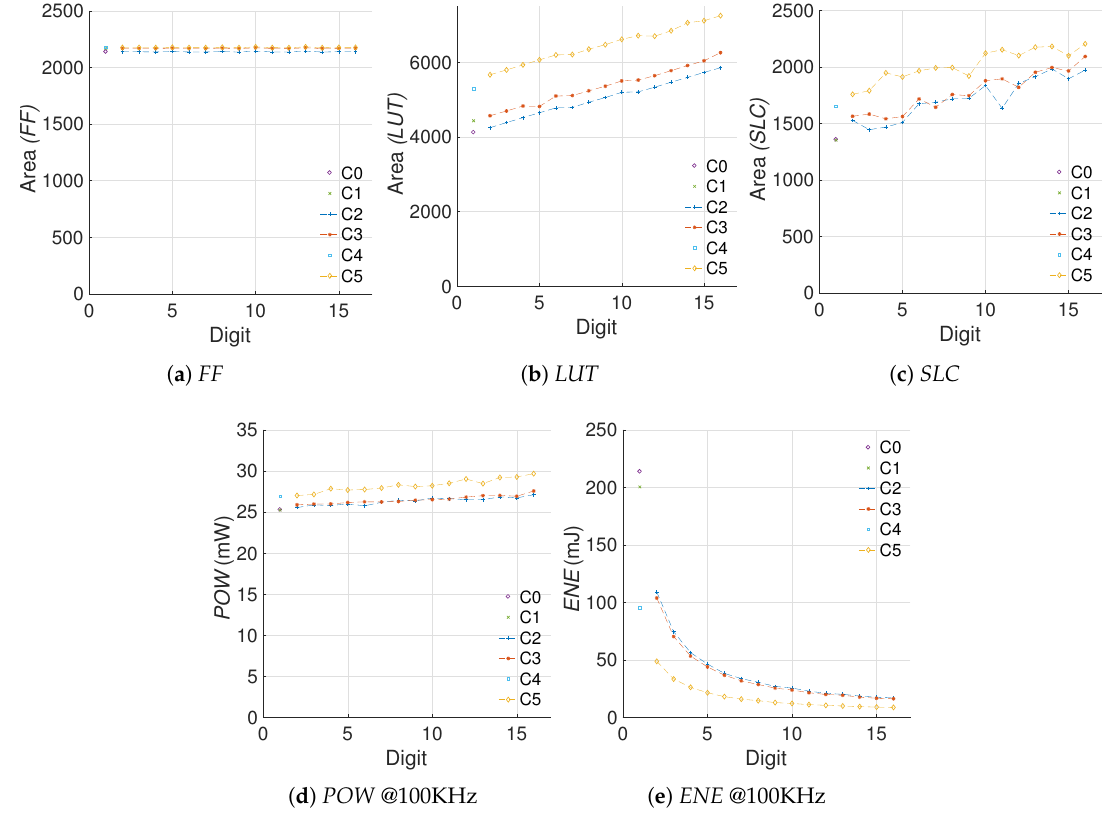
Figure 6. FPGA area, power dissipation, and energy consumption for the different kP architectures.